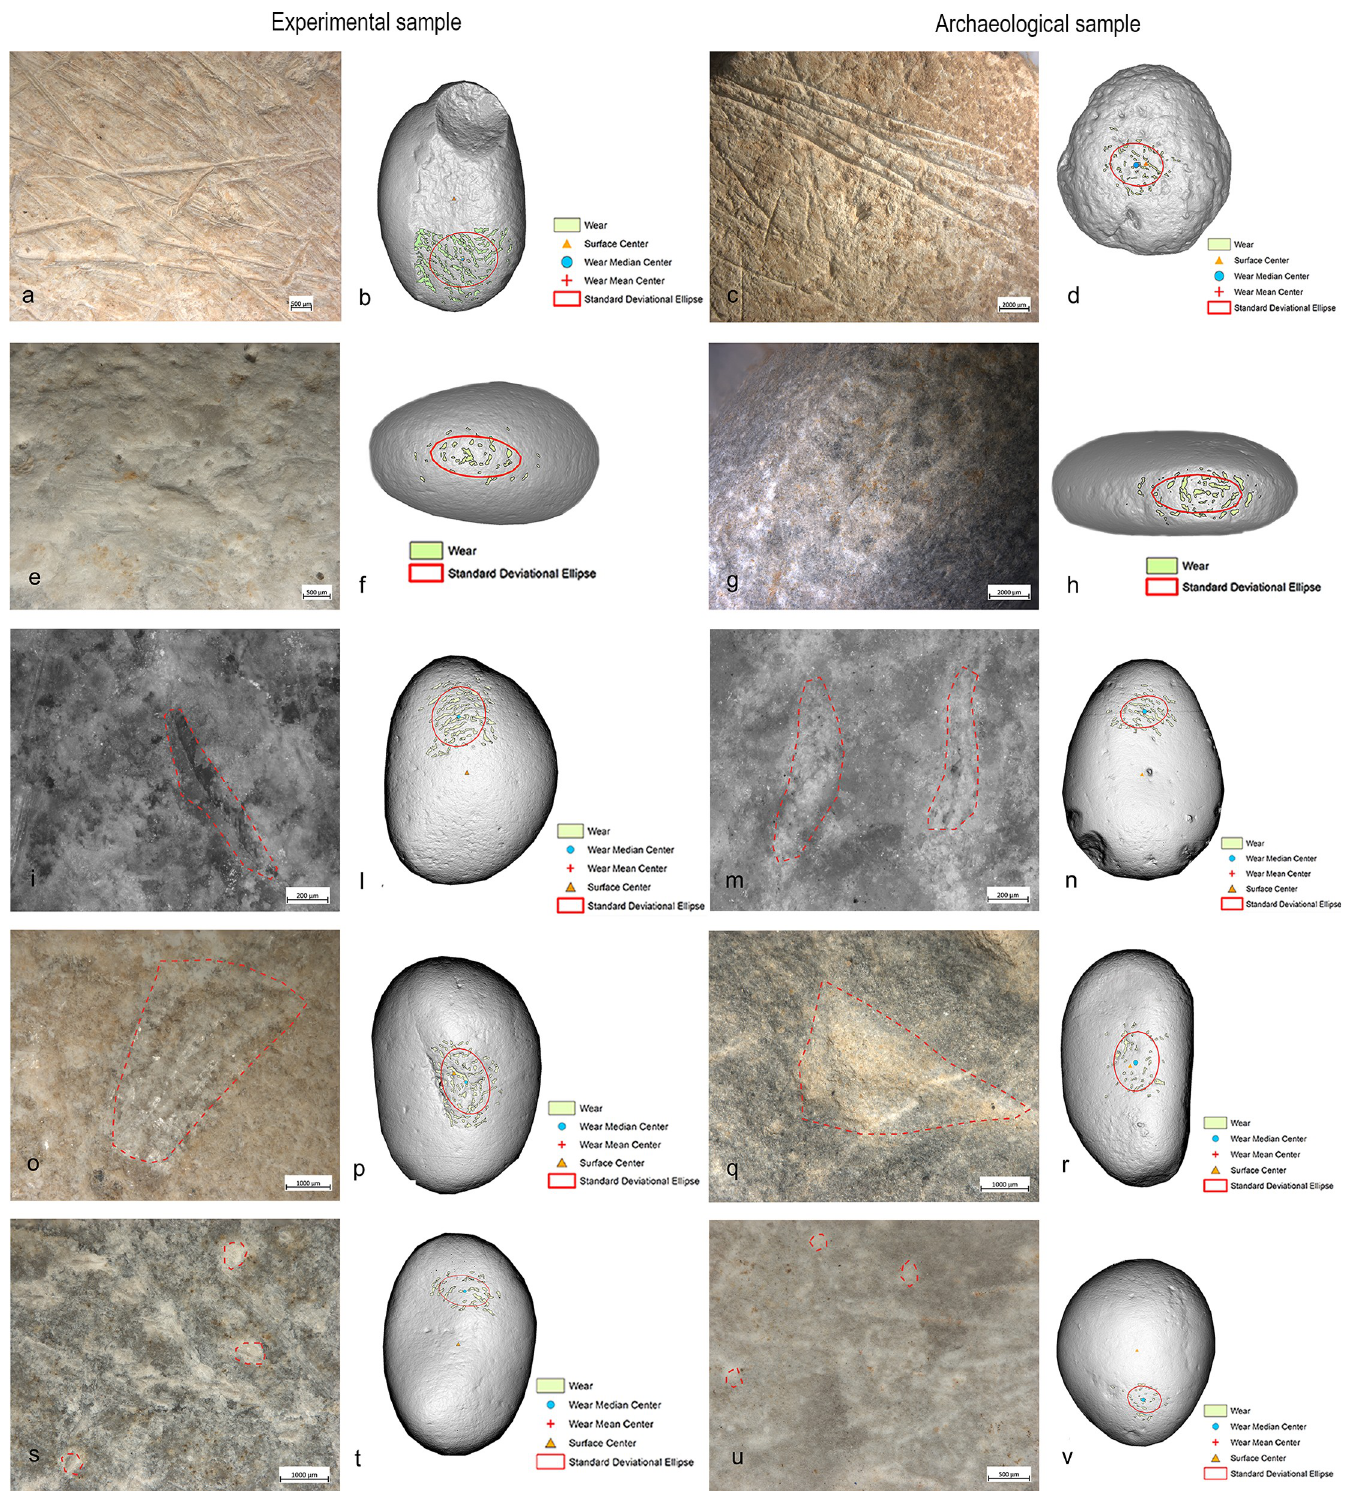
Fig 33. Comparison between the experimental and archaeological use wear and their distribution. (a) Experimental striations (10x) related to the overhang abrasion, localised (b) on the flat surface of the pebble; (c) archaeological striations (10x), localised (d) on the flat surface of the sample; (e) experimental pits (15x) related to core maintenance/bladelets removal, with sub-oval morphology, localised (f) around the short edge of the pebble; (g) archaeological pits (10x) with sub-oval morphology, (h)